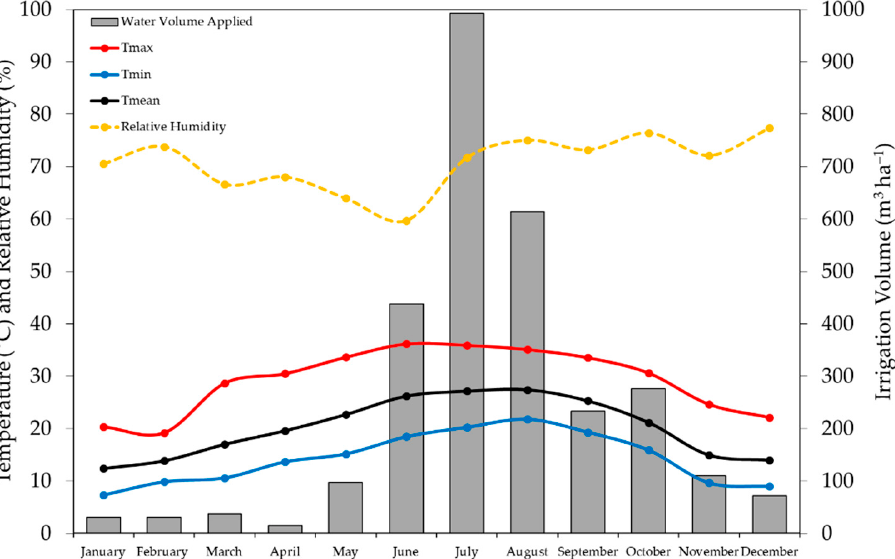
Figure 2. Monthly average temperatures, relative humidity, and irrigation volumes applied at the experimental site.